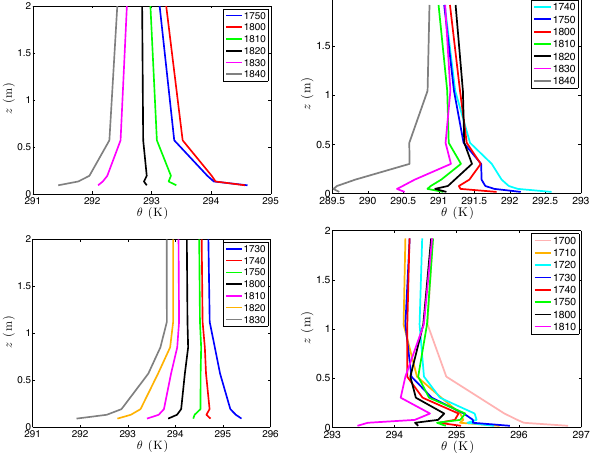
Figure 2. Temporal evolution of vertical potential temperature pro- files with an observed LTM on 24 June 2011 (top) and 1 July 2011 (bottom) measured at T1 (left) and T2 (right).